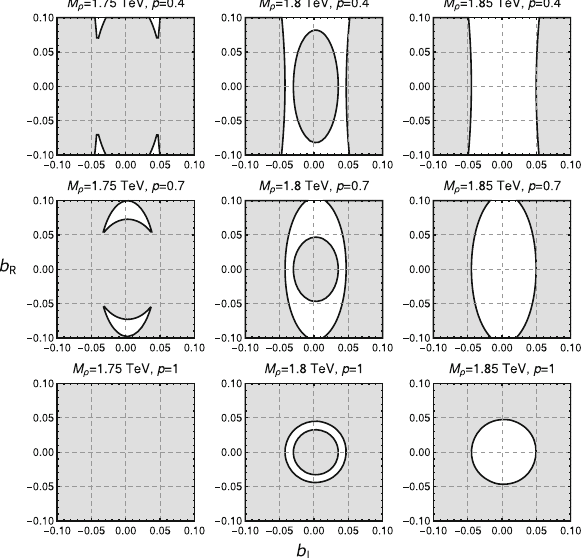
Fig. 12 The grid of graphs of the excluded regions of the ( b L , b R ) - plane (gray area) when g (cid:2)(cid:2) = 18. The mass changes from graph to graph in the left-to-right direction through the values of 1 . 75, 1 . 80, and 1 . 85 TeV. The p parameter changes from the top to the bottom through the values of 0 . 4, 0 . 7, and 1 .